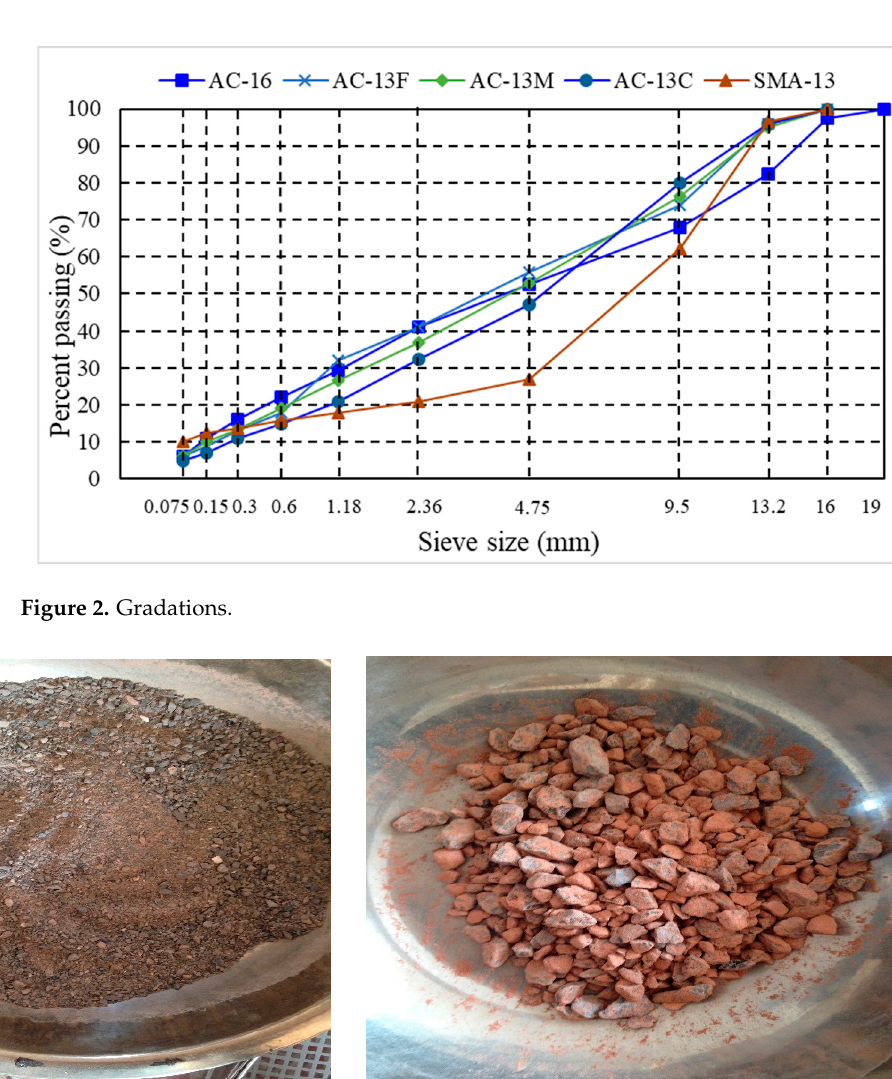
Figure 2. Gradations.